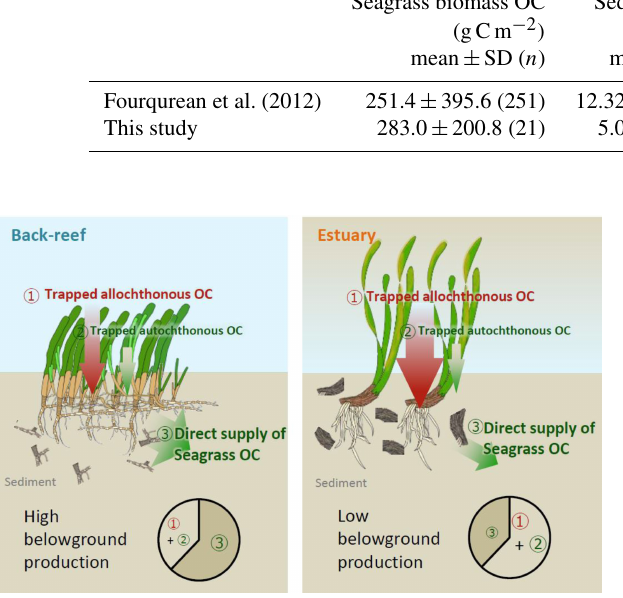
Figure 8. Proposed mechanisms of OC accumulation at our study sites. At the back-reef site dominated by Thalassia hemprichii , di- rect supply of recalcitrant belowground seagrass detritus is a major pathway of OC sed accumulation. At the estuarine site dominated by Enhalus acoroides , trapping of suspended autochthonous and al- lochthonous OC is the major pathway of OC accumulation. A differ- ence in the turnover rate of belowground biomass likely caused the major mechanism of OC accumulation to differ between the